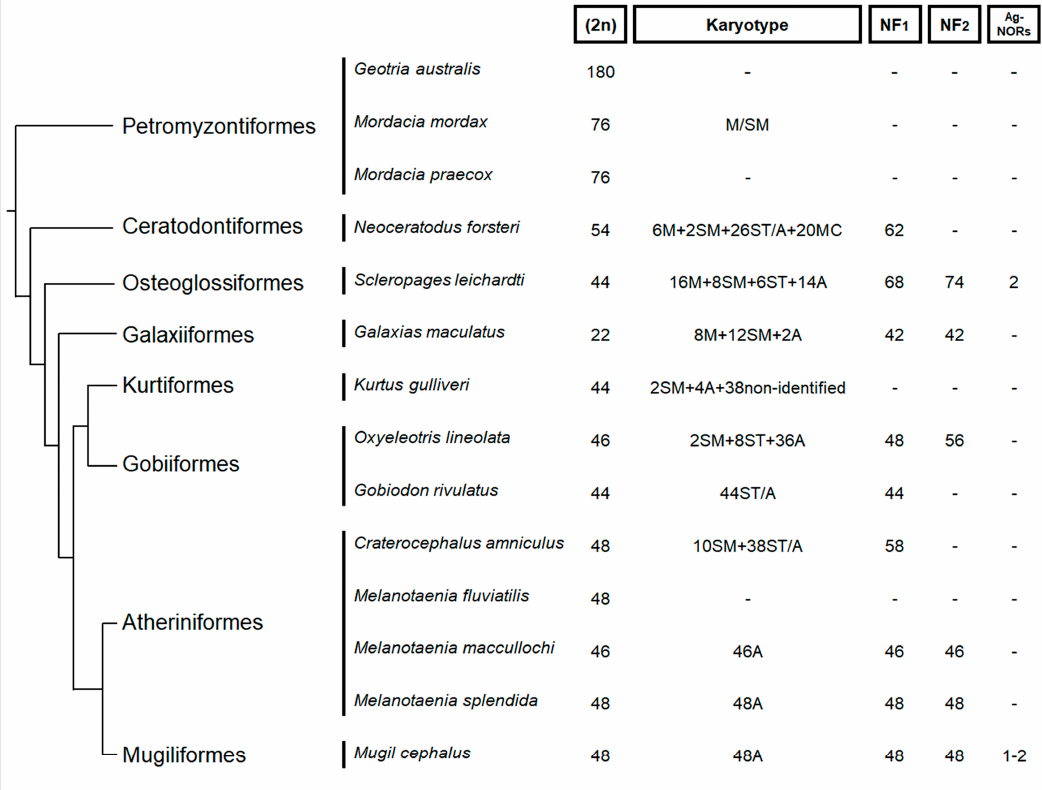
Figure 2. Summary of cytogenetic studies of Australian fish showing the nature of chromosomes from Arai [24], Ezaz, et al. [22] and Majtánová, et al. [23]. Phylogeny adopted from Betancur-R , et al. [25]; M = Metacentric; SM = Submetacentric; ST = Sub-telocentric; A = Acrocentric; MC = Micro Chromosome; NF 1 = Fundamental arm number, when M and SM are counted as two-armed; NF 2 = Fundamental arm number, when M, SM and ST are counted as two-armed; Ag-NORs = Number of transcriptionally active nucleolus organiser regions containing chromosomes.